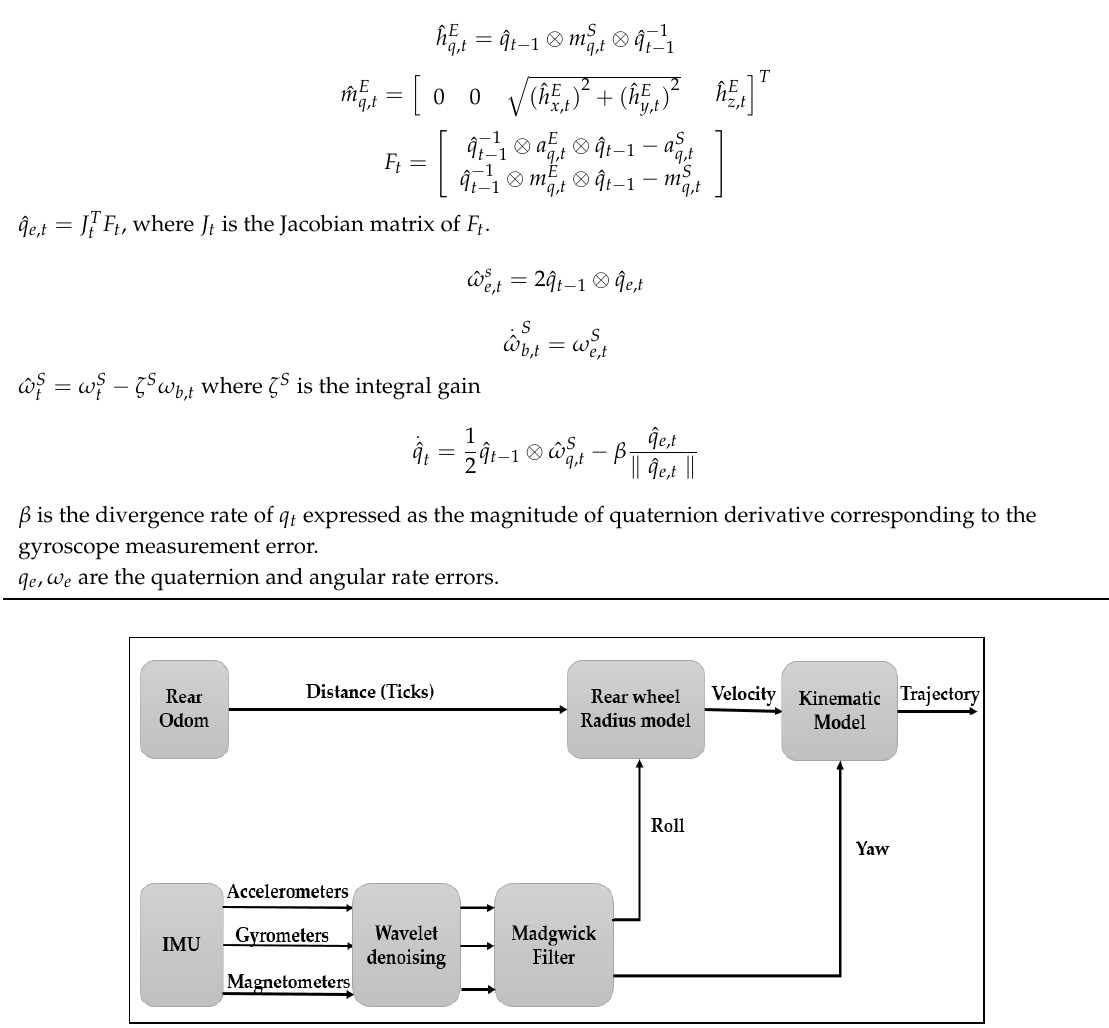
Figure 13. Schematic diagram of the new INS/odometer integration model.